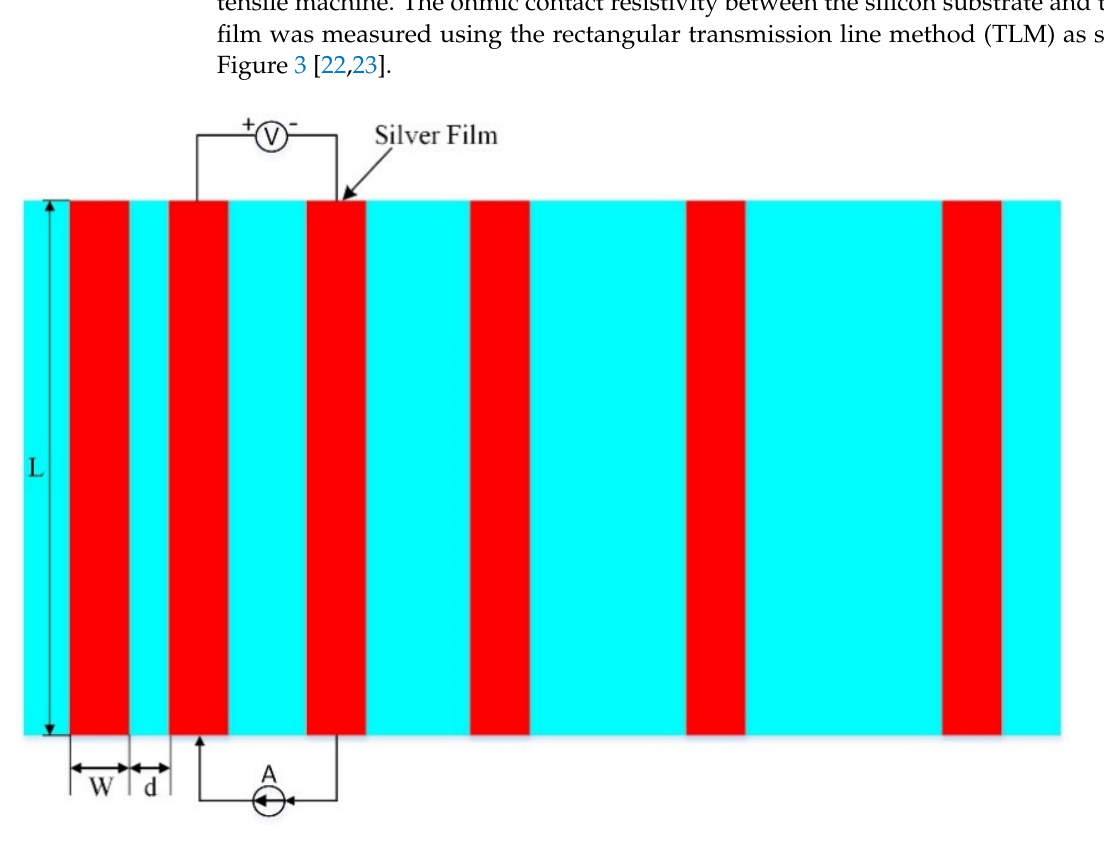
Figure 3. Schematic of the TLM method for the contact resistivity measurements. L = 20 mm, W = 1 mm, and d is from 0.5 mm to 2.5 mm with an increment of 0.5 mm.